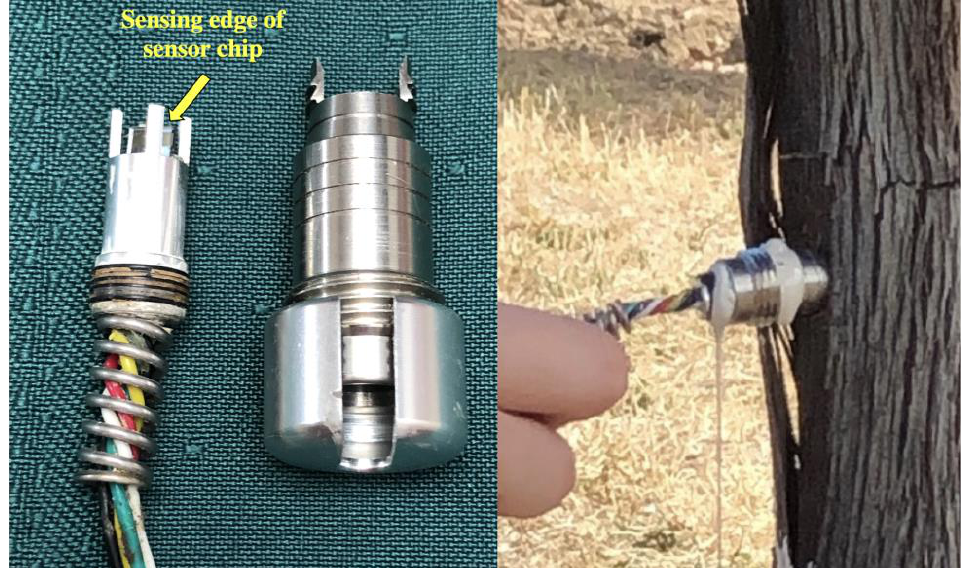
Figure 2. Photographs of the FloraPulse microtensiometer and installation. The sensing edge of the chip is held in a probe and held in contact with the xylem by the outer steel sleeve. After driving the sleeve into the stem, the sleeve is a drill guide, and a liquid clay paste is injected before the sensor probe is inserted. The nut of the sleeve then holds the spring-loaded probe in